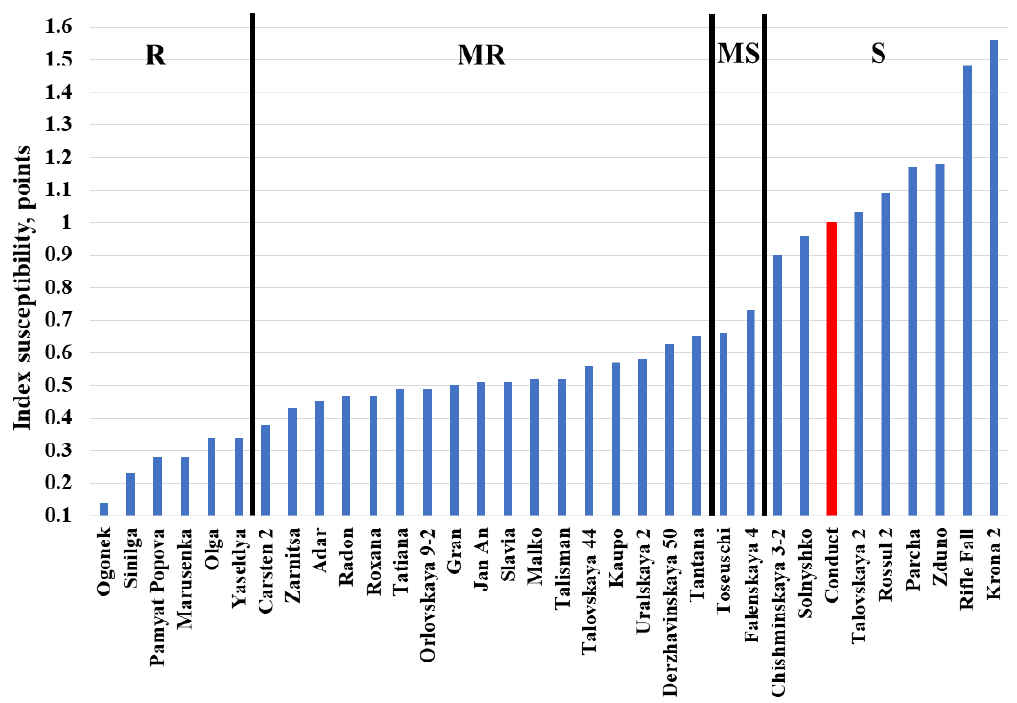
Figure 4. Index susceptibility (IS) showing the level of quantitative resistance of rye accessions to Microdochium nivale . The analysis was performed using the detached leaf assay method under laboratory conditions. R—resistant accessions; MR—moderately resistant accessions; MS—moderately susceptible accessions; S—susceptible accessions. The IS of the susceptible check Conduct is shown in the red column.